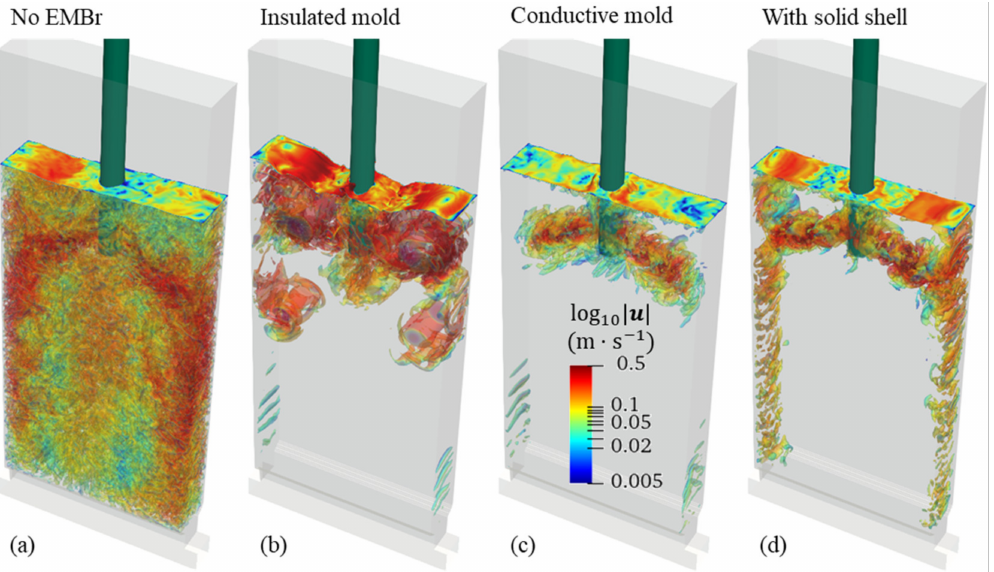
Figure 14. Turbulent flow structures ( Q crit = 100), SEN immersion depth of 50 mm ( a ) Case 0B; ( b ) Case 1B; ( c ) Case 2B; ( d ) Case